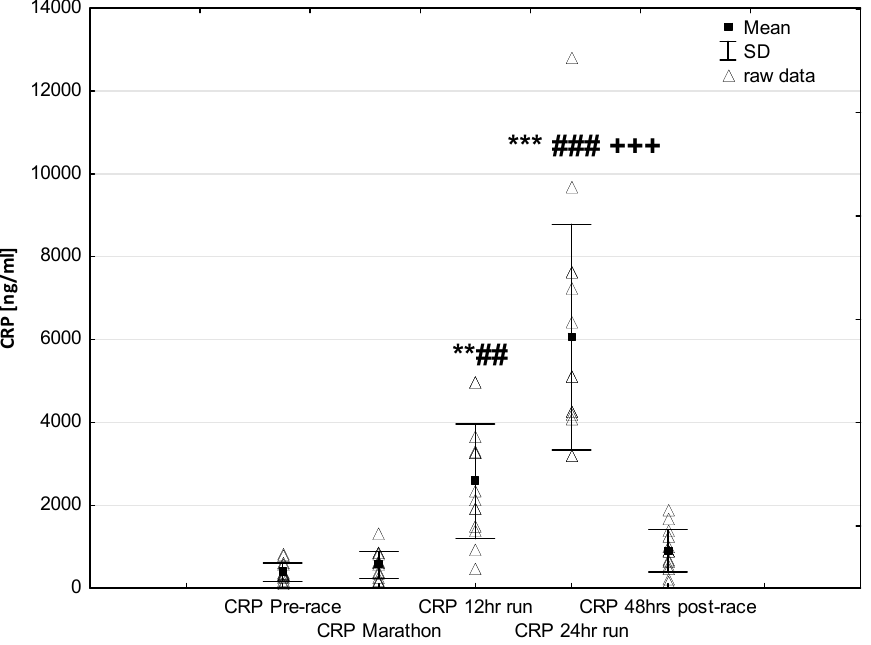
Figure 3. Ultra-marathon-induced changes in serum cardiac specific troponin T (cTnT). *** p < 0.001 versus the corresponding pre-race value (Pre-race); ### p < 0.001 versus the corresponding post-marathon value (Marathon); ++ p < 0.01 versus the corresponding post 12-h run value (12-h run).